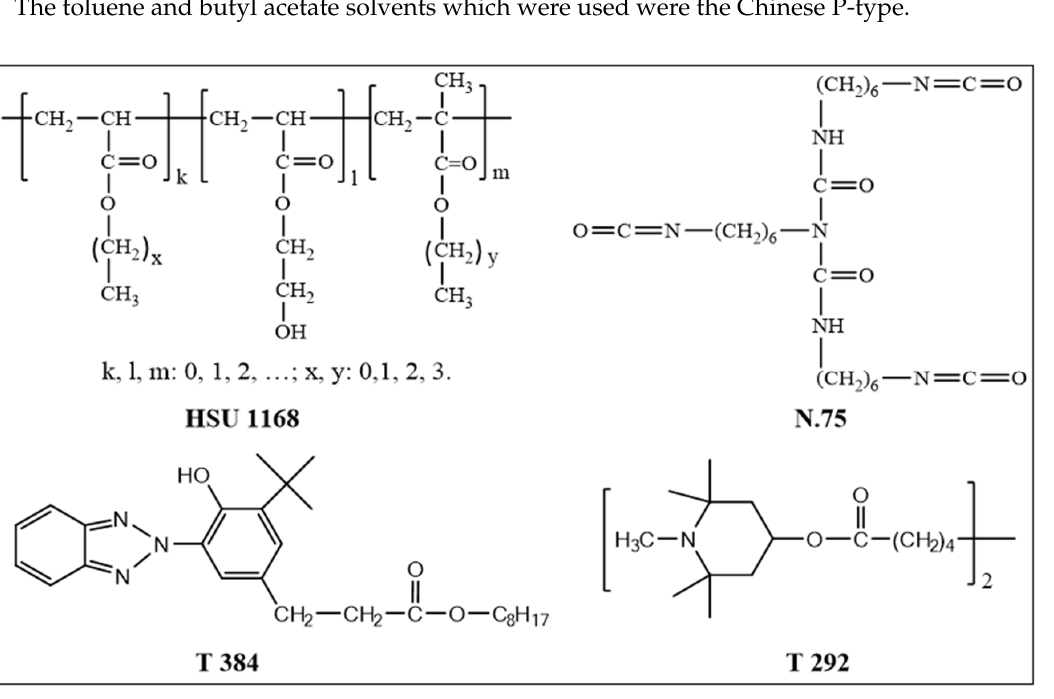
Figure 1. Chemical structures of used compounds.